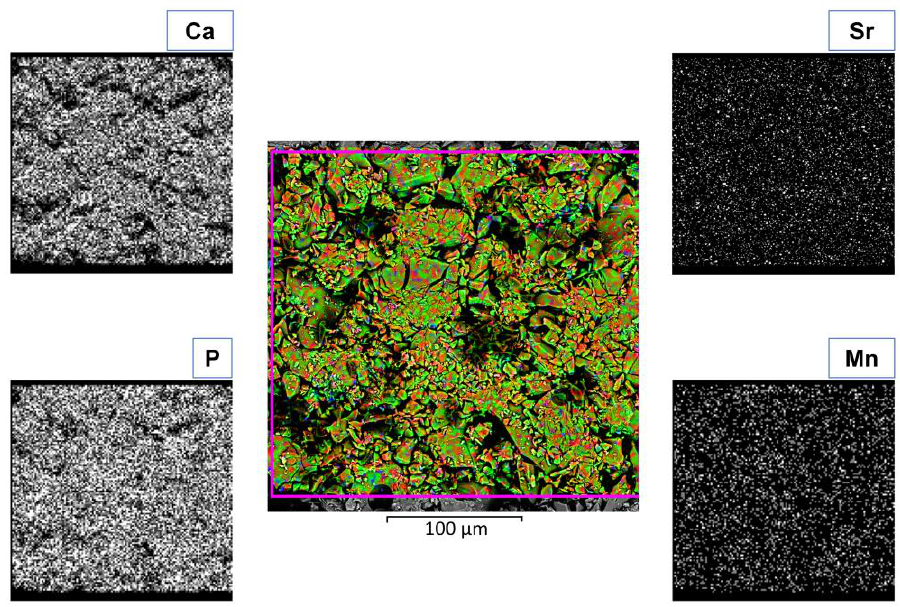
Figure 6. SEM-EDX composition of Mn,Sr-TCP powder.